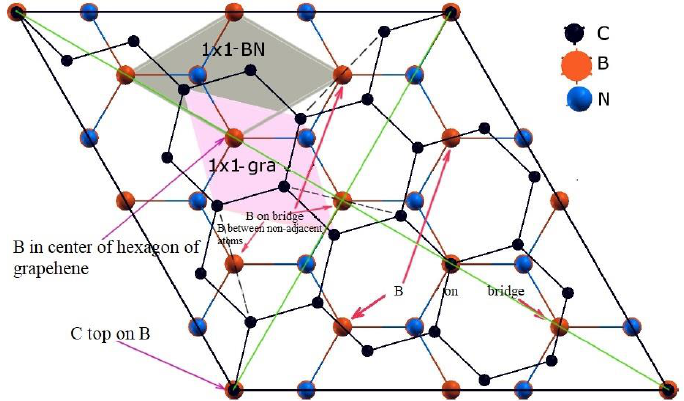
√ √ 13 × 13 -graphene /2